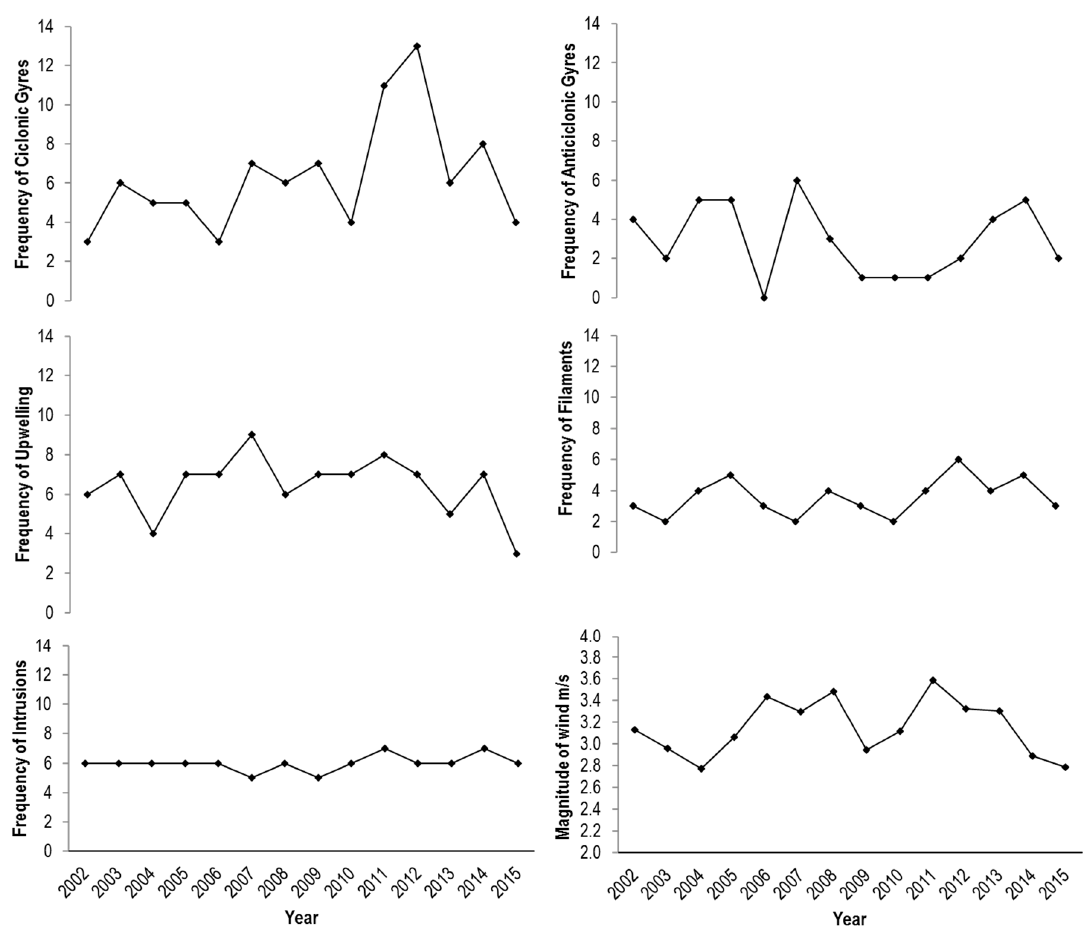
Figure 3. Cumulative annual frequency observed of mesoscale phenomena and winds in the central and southern coastal region of Sonora and adjacent deep zone in the Gulf of California.